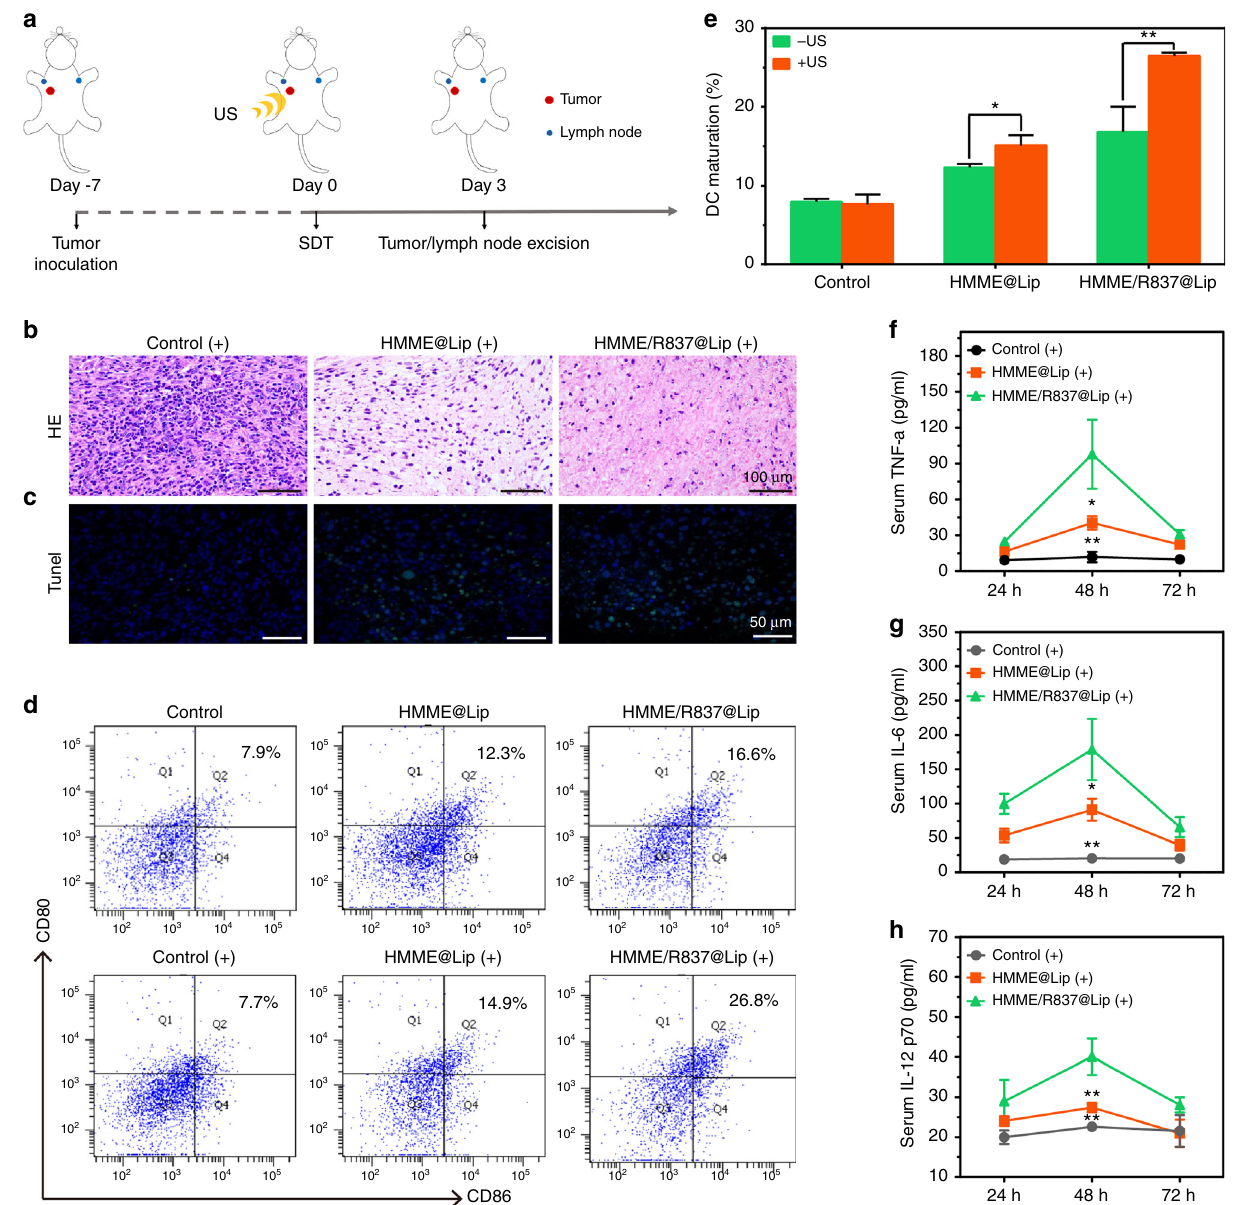
Fig. 4 In vivo HMME/R837@Lip-augmented SDT for inducing cell apoptosis and/or necrosis, promoting DC maturation and stimulating the expression of proin fl ammatory cytokines. a Schematic illustration of the experiment design to assess the in vivo sonotoxicity and the immune responses as triggered by HMME/R837@Lip-augmented SDT; b , c in vivo apoptosis and/or necrosis of the tumour induced by HMME/R837@Lip-augmented SDT, as shown by H&E staining (scale bar = 100 μ m) and TUNEL assay (scale bar = 50 μ m); d , e DC maturation in the tumour-draining lymph nodes induced by HMME/ R837@Lip-augmented SDT on mice bearing 4T1 tumours, as assessed by fl ow cytometry after staining with CD11c, CD80, CD86 and live dead; f – h cytokine levels of TNF- α , IL-6 and IL-12p70 in sera from mice isolated from 24 to 72 h after HMME/R837@Lip-agumented SDT treatment. Data are expressed as means ± SD ( n = 3). Statistical signi fi cances were calculated via Student ’ s t test, * p < 0.05 , ** p < 0.01 were further con fi rmed by the high percentage of TUNEL- positive cells (green fl uorescence) in TUNEL assay (Fig. 4c). integration of the R837 immune adjuvant endows HMME/ R837@Lip with a much stronger ability to promote DC maturation (Fig. 4d, e) and secretes immune cytokines in vivo (Fig. 4f – h), which enables the immunotherapy against solid tumours combined with SDT. In detail, SDT with HMME/ R837@Lip induced high levels of DC maturation (26.8%), which was much higher than the composite nanosonosensitisers alone (16.6%) and HMME@Lip (14.9%). Therefore, after the tumours NATURE COMMUNICATIONS| (2019) 10:2025